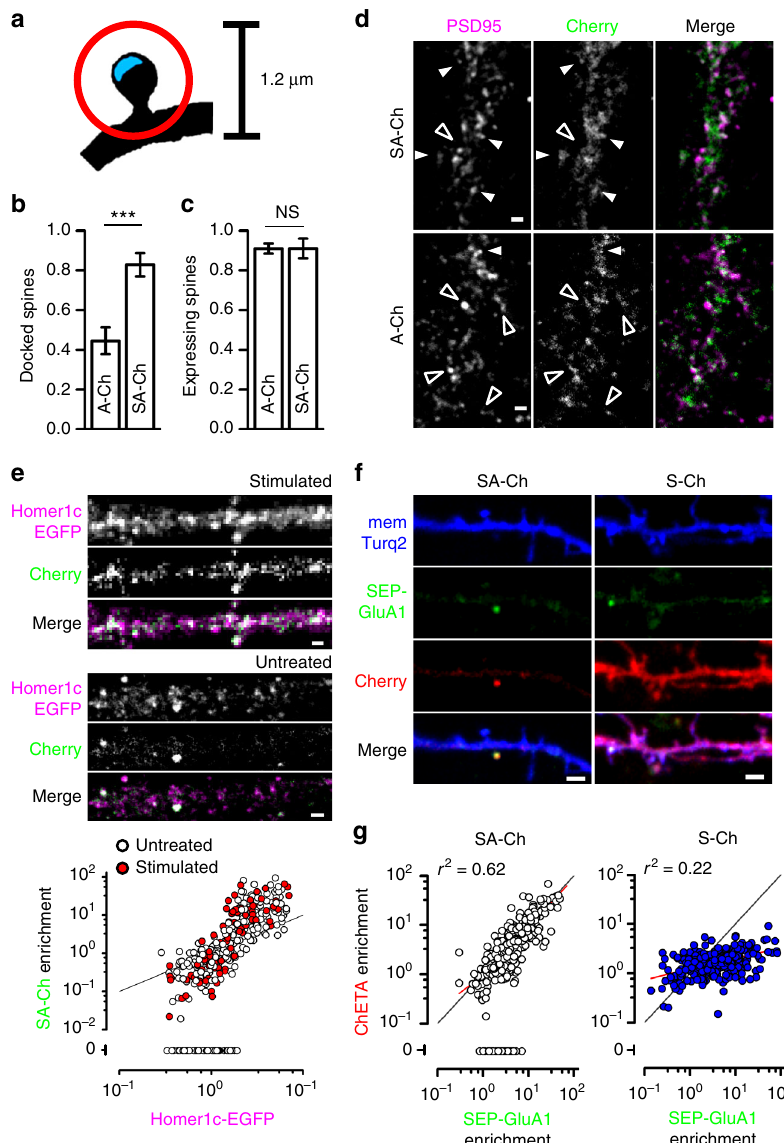
Fig. 2 Synergistic action of RNA and protein regulatory sequences. SYN tag confers synaptic localization of SA-Ch protein ( a – d ), whereas RNA sequences maps its expression to potentiated spines ( e – g ). a Schematic drawing for the determination of “ docked ” vs. positive but non- “ docked ” spines. Cherry fl uorescence peaks within a circle of 1.2 μ m diameter (red circle) centered on the postsynaptic density (PSD - blue area) for positive spines, and on the PSD for “ docked ” spines. Quanti fi cation of “ docked ” b and total positive spines ( c following cLTP treatment (see Methods) for A-Ch and SA-Ch. Bars are mean ± SEM. *** P < 0.001 two-tailed Student ’ s t -test. NS, not signi fi cant at the α = 0.05 level. d Representative dendrites of neurons expressing the two constructs. White arrowheads indicate “ docked ” spines, empty arrowheads positive, non- “ docked ” spines. Another example is reported in Supplementary Fig. 7a. e SA-Ch co-localizes with PSD marker Homer1c-EGFP. In stimulated as well as in unstimulated neurons, SA-Ch was expressed at Homer1c-EGFP puncta (top). SA-Ch correlation with Homer1c-EGFP is supralinear, indicating that SA-Ch is preferentially enriched at spines with larger PSD (bottom graph). Spines that do not express SA-Ch are assigned a value of zero. White dots are spines from unstimulated neurons, red dots from stimulated ones, black line represents the diagonal. Because the plot has double-log scale, any linear correlation has unitary slope and is parallel to this line. f Comparison of SA-Ch and S-Ch expression: SA-Ch is only expressed at SEP-GluA1-tagged spines, whereas S-Ch has no preference for SEP-GluA1-positive spines. g SA-Ch (grey dots) signi fi cantly correlates with SEP-GluA1 expression in a linear fashion, whereas S-Ch (blue dots) does not. A proportion of SEP-GluA1- positive spines do not express SA-Ch and those spines are assigned an enrichment value of zero. Red lines indicate the regression lines. Scale bar, 1 μ m ( d , e ) and 2 μ m ( f